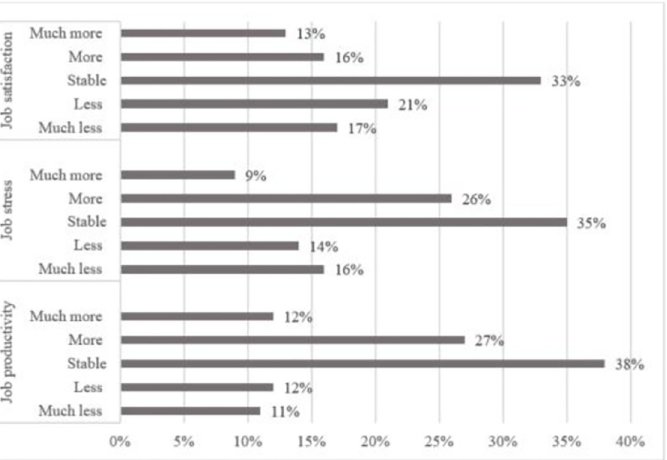
Fig 1. Descriptive statistics of the evolution of subjective well-being and productivity before and during the lockdown. Source : First wave of the Survey on the COVID-19 socio-economic impacts in Luxembourg (SEI), ‘home office’ module, LISER and University of Luxembourg. Notes : Weighted figures. The sub-sample used to study job stress covers 306 teleworkers, for the two others we have 438